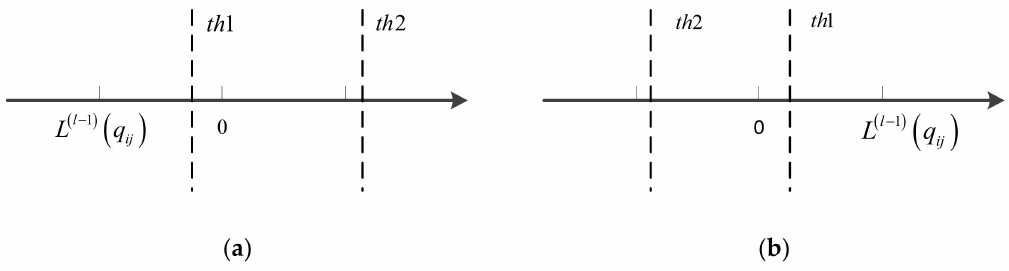
Figure 1. Schematic diagram of reliable message determination for the dual threshold self-corrected minimum sum (DT-SCMS)